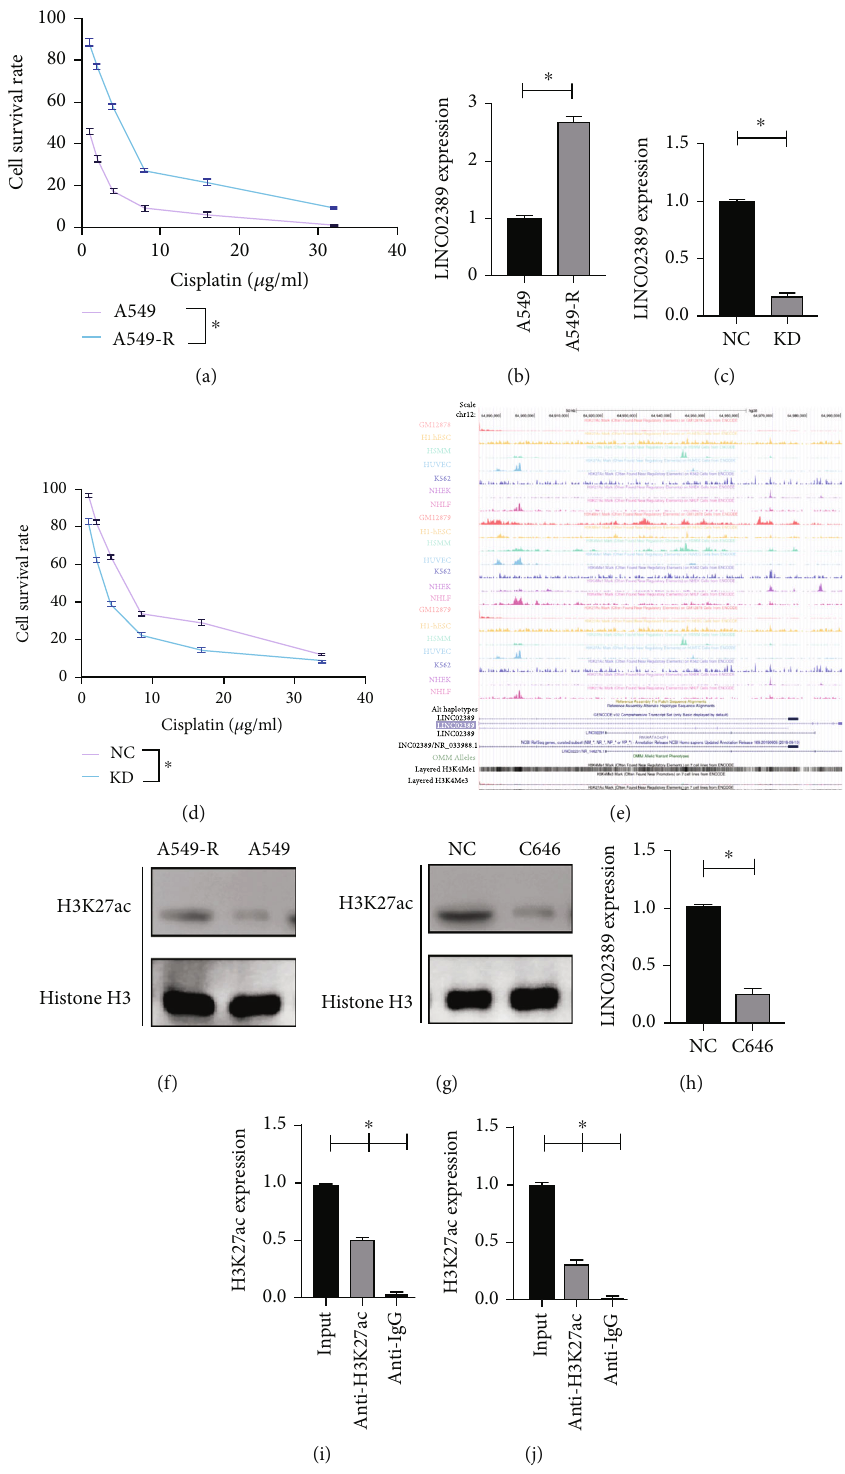
Figure 3: (a) CCK-8 assay to evaluate the IC50 of A549 and A549-R (cisplatin resistant) to cisplatin. (b) LINC02389 expression in A549-R compared with A549. (c) Knockdown of LINC02389 expression in A549-R. (d) CCK-8 assay to evaluate the e ff ect of LINC02389 knockdown in IC50 of A549-R to cisplatin. (e) UCSC genome browser to explore the H3K27ac enrichment. (f) H3K27ac expression in A549-R compared with A549. (g) H3K27ac expression in A549-R treated with C646. (h) LINC02389 expression in A549-R treated with C646. (i) ChIP assay to evaluate the enrichment of H3K27ac in the promoter region of LINC02389 in A549-R. (j) ChIP assay to evaluate the enrichment of H3K27ac in the promoter region of LINC02389 in A549-R treated with